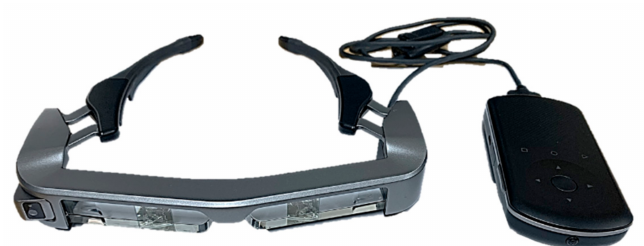
Figure 1. Example of smart glasses (Moverio BT-350, Epson, Suwa,